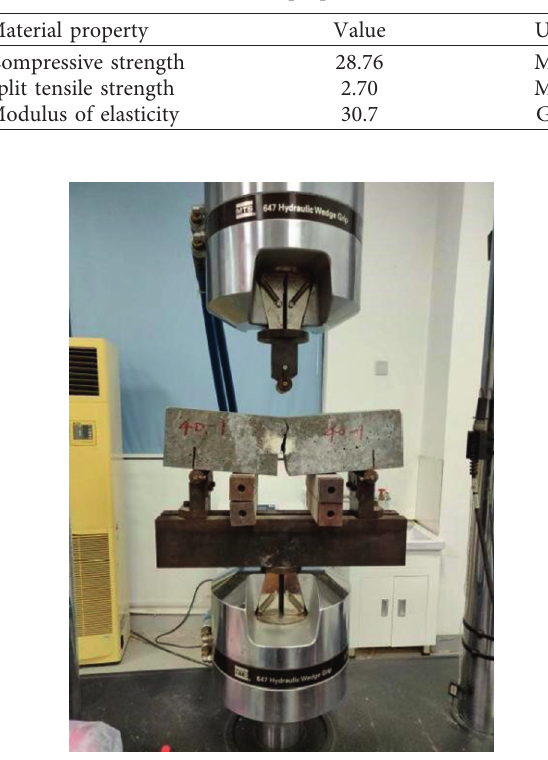
Figure 1: Diagram of experimental apparatus for fracture.